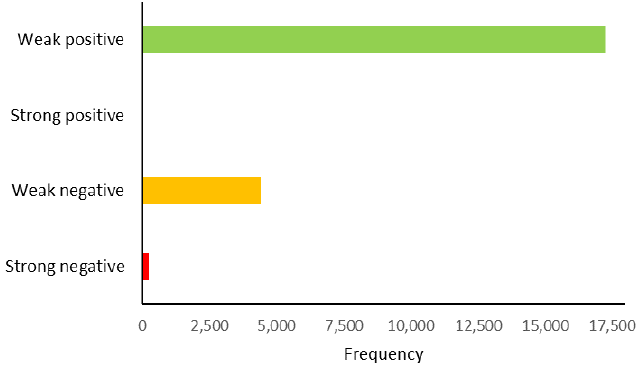
Figure 5. Distribution of weak and strong slopes.